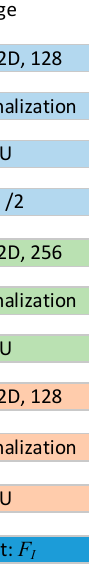
Figure 2. Network architecture of the 2D backbone.